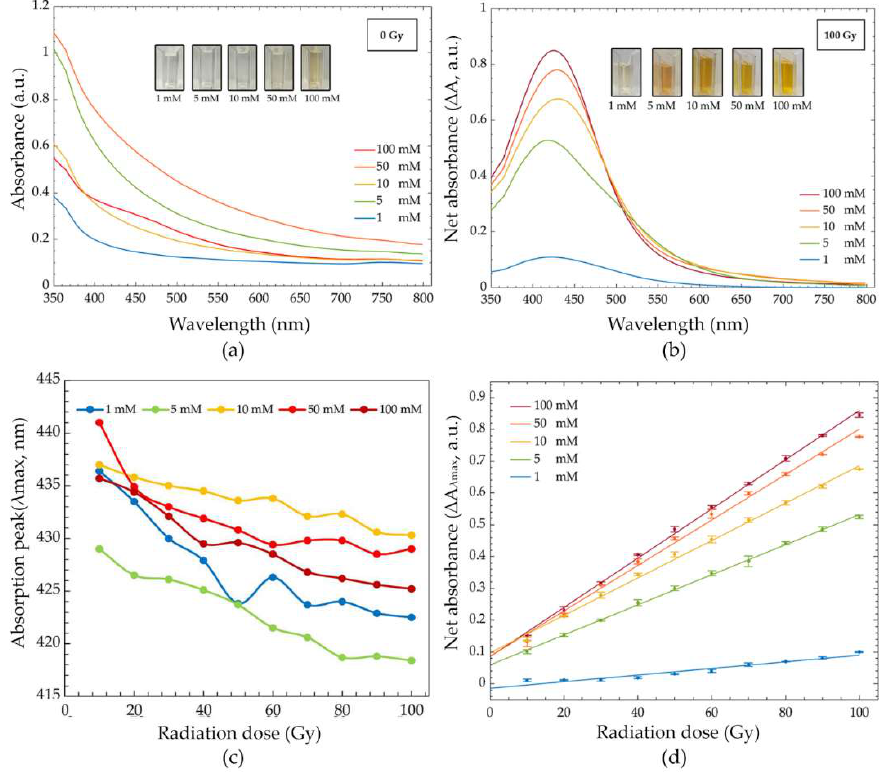
Figure 4. ( a ) Absorption spectra of the PVA/AgNPs solution before irradiation (1, 5, 10, 50, and 100 mM), ( b ) net absorption spectra after 100 Gy irradiation (1, 5, 10, 50 and 100 mM), ( c ) absorption peak ( λ max ) in the dose range of 0–100 Gy (1, 5, 10, 50, and 100 mM), and ( d ) dose response curves in the dose range of 0–100 Gy (1, 5, 10, 50 and 100